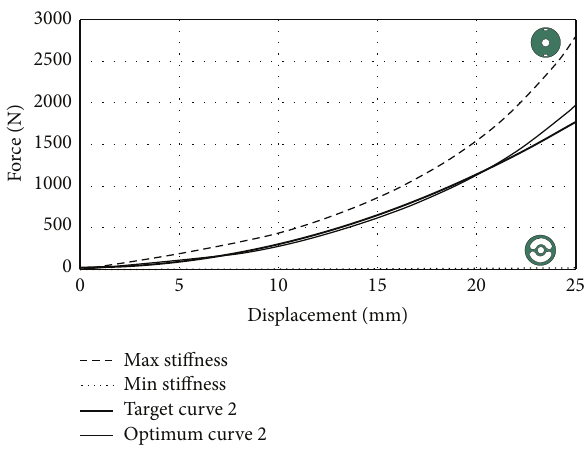
Figure 12: Optimization results for target curve